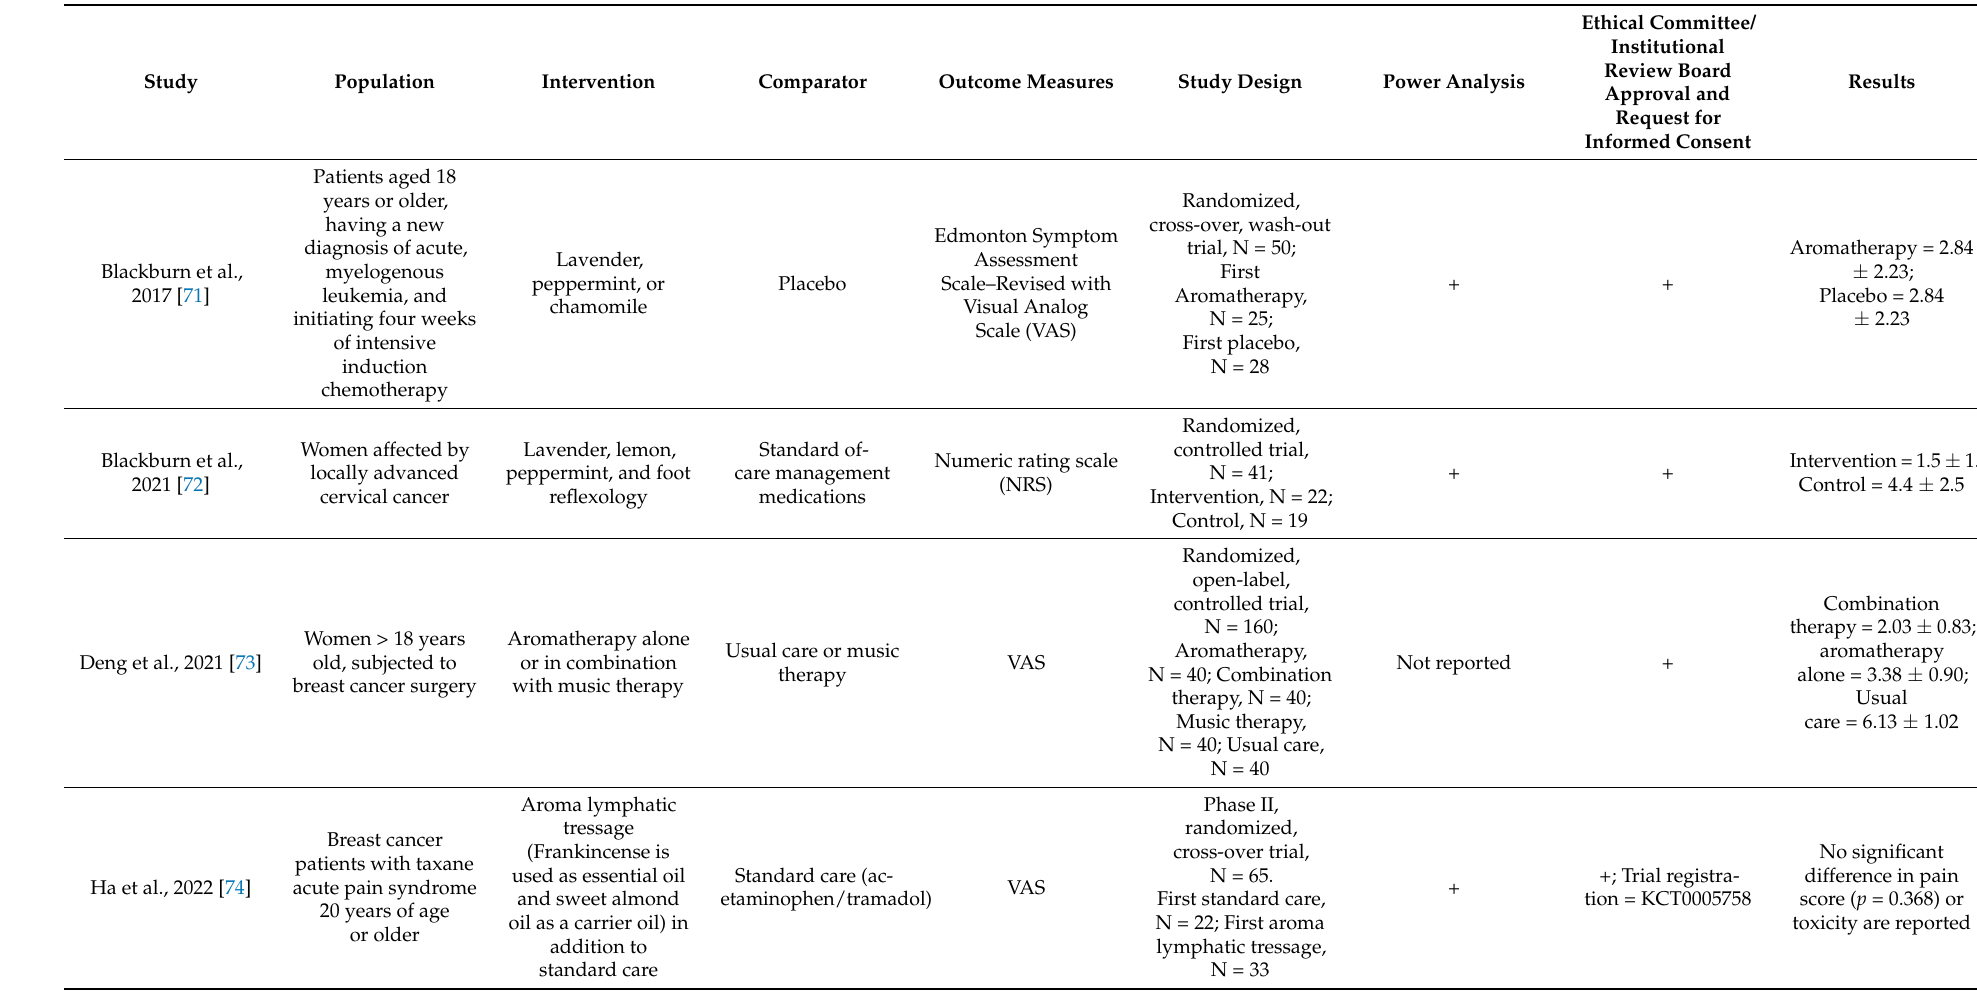
Table 1. Main characteristics of the studies included in the analysis according to the Preferred Reporting Items for Systematic Reviews and Meta-Analyses